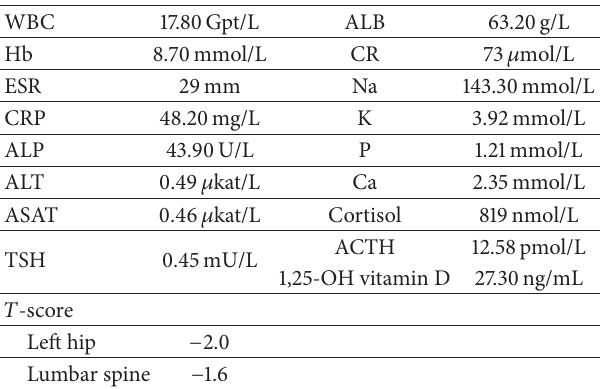
Table 1: Summary of blood examination and